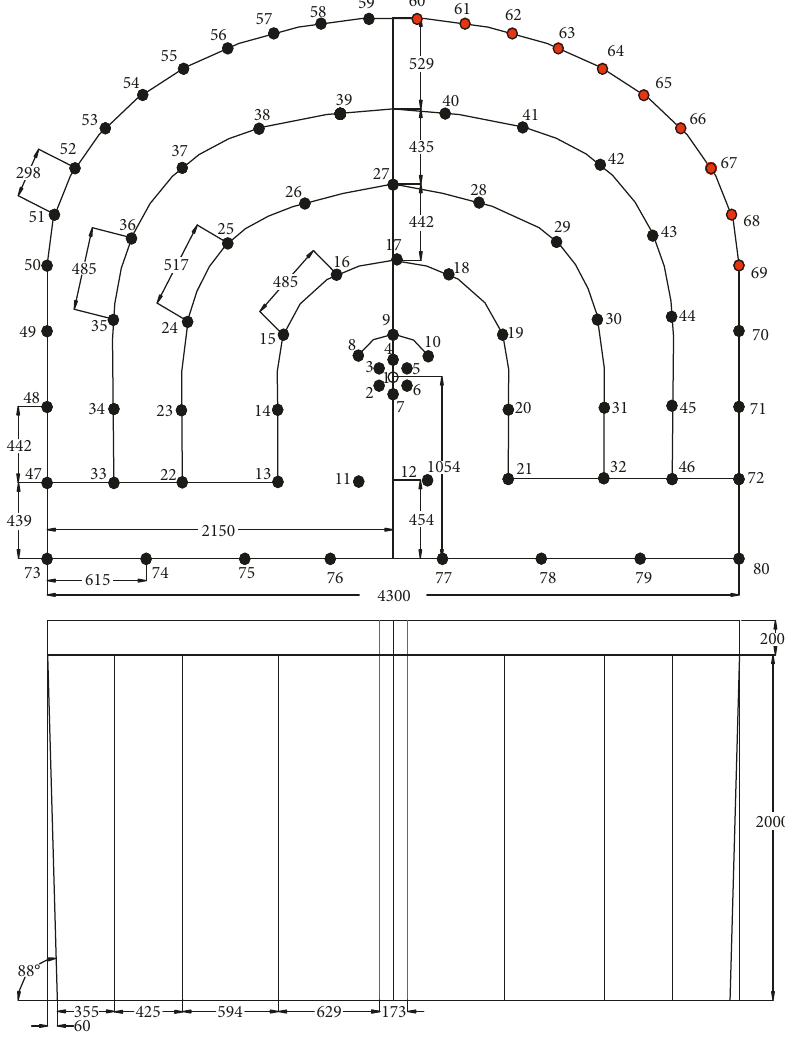
Figure 5: Blasting scheme of the slit charge technology. Table 1: Blasting parameters table for the